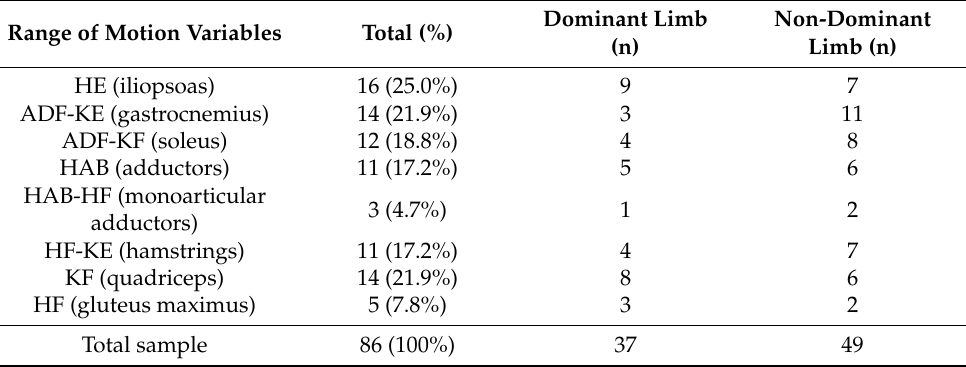
Table 3. Inter-limb ROM asymmetries (favoring dominant or non-dominant limb) in each movement assessed of basketball